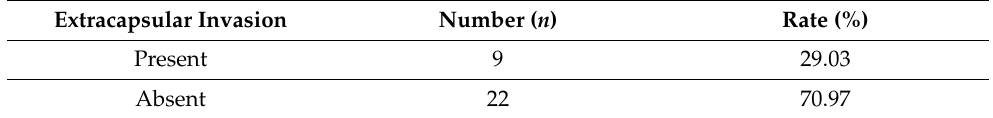
Table 6. Extracapsular invasion in group 1.2.